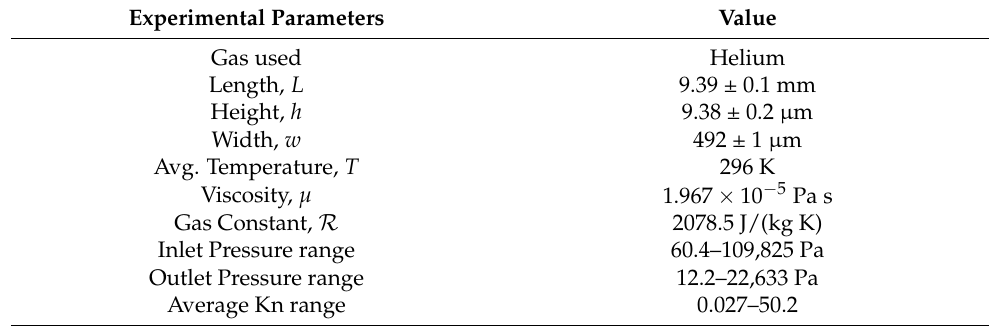
Table 1. Experimental conditions of Ewart et al. [13] for a pressure ratio of P = 5. Experimental